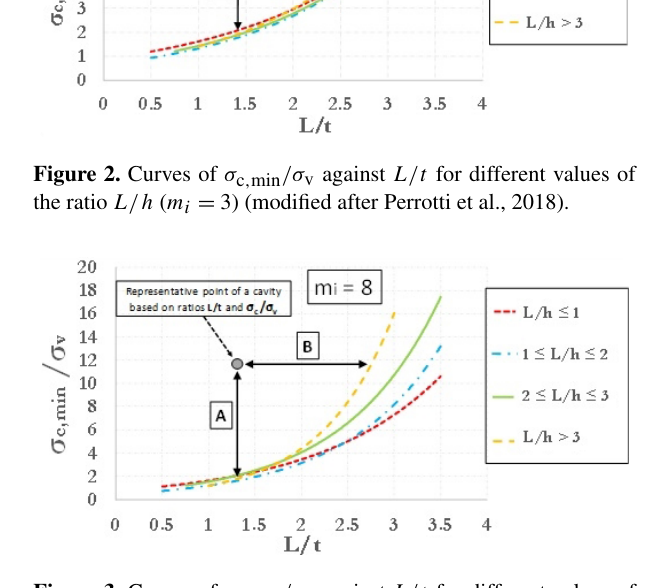
Figure 3. Curves of σ c , min /σ v against L/t for different values of the ratio L/h ( m i = 8) (modified after Perrotti et al., 2018).